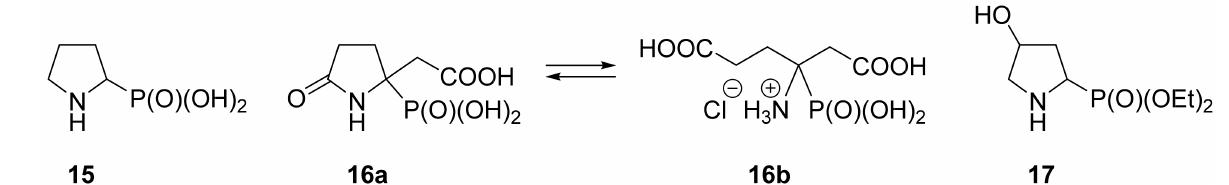
Figure 2. Phosphoproline 15 and its functionalized analogues 16 and 17